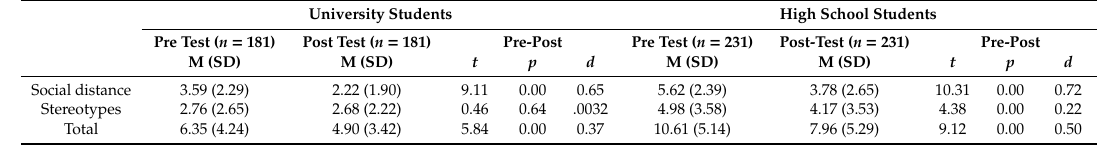
Table 4. Pre-test / post-test di ff erences among high school students and university students.